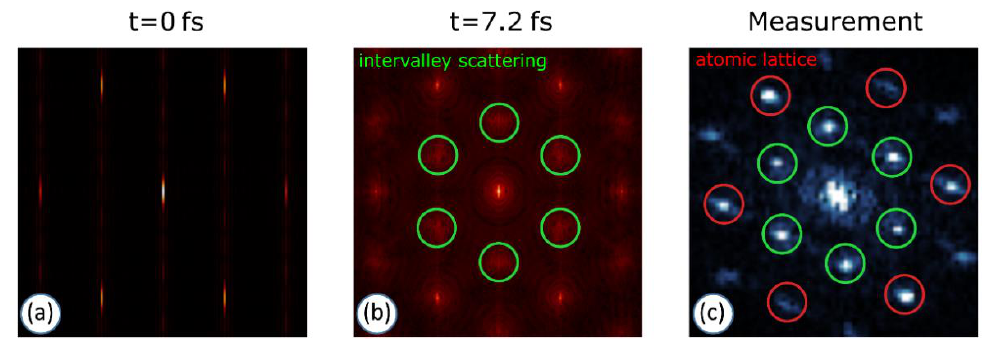
Figure 3. Simulated and measured FFT-LDOS maps. ( a ) Two-dimensional Fourier transform (2D FFT) of the probability density of the initial wave packet shown on Figure 2d. ( b ) 2D-FFT of the probability density at t = 7.2 fs (Figure 2f). ( c ) 2D-FFT of a topographic STM image.